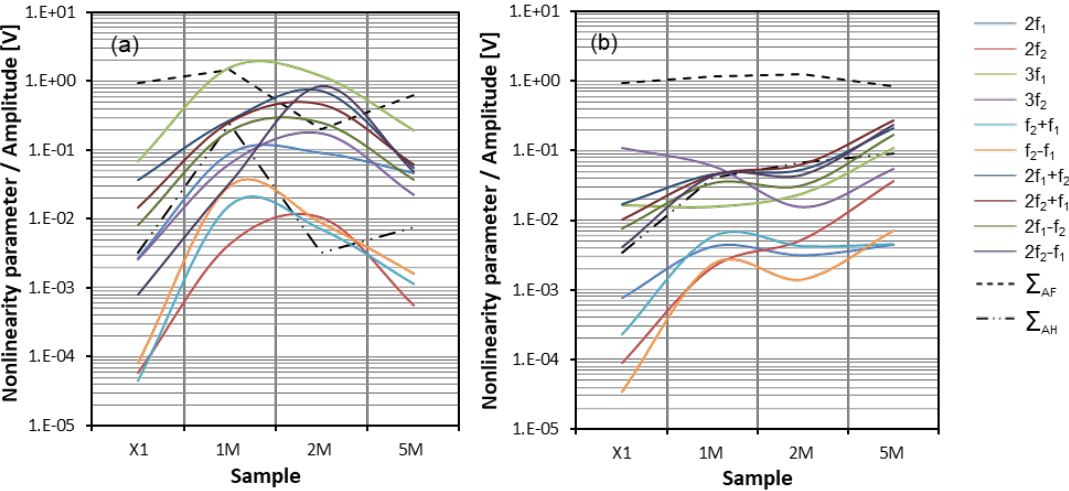
Figure 14. Nonlinearity parameter: ( a ) f 1 = 3 MHz, f 2 = 5 MHz, α = 50°; ( b ) f 1 = 4 MHz, f 2 = 5 MHz, α = 50°.